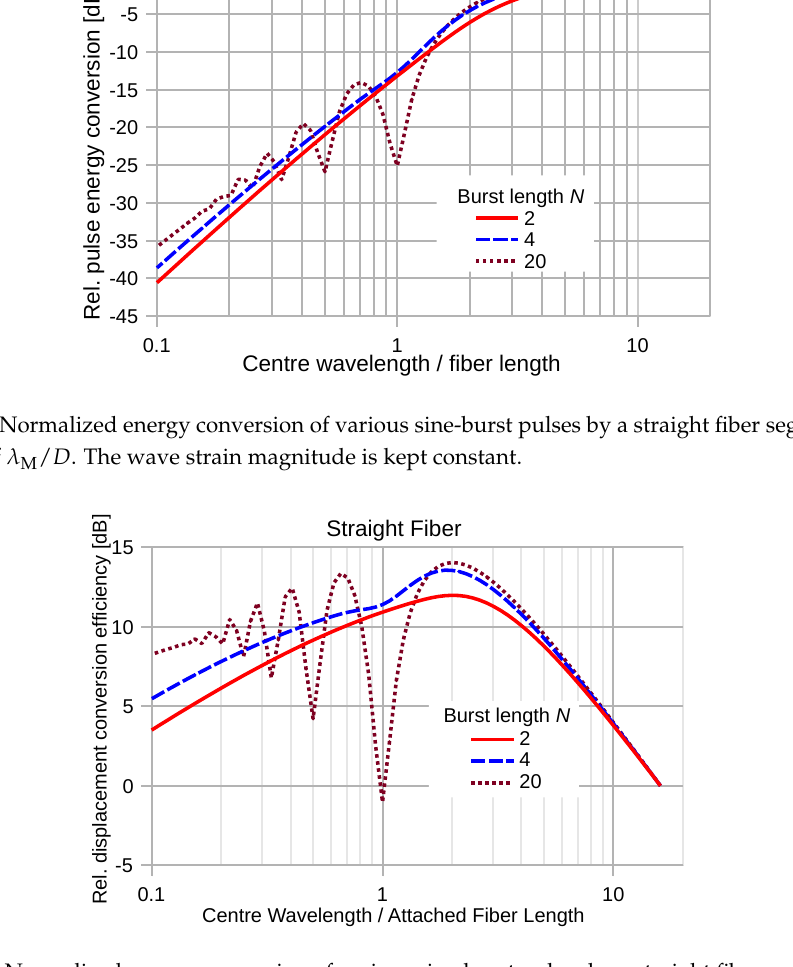
Figure 12. Normalized energy conversion of various sine-burst pulses by a straight fiber segment as a function of λ M / D . The wave displacement magnitude is kept